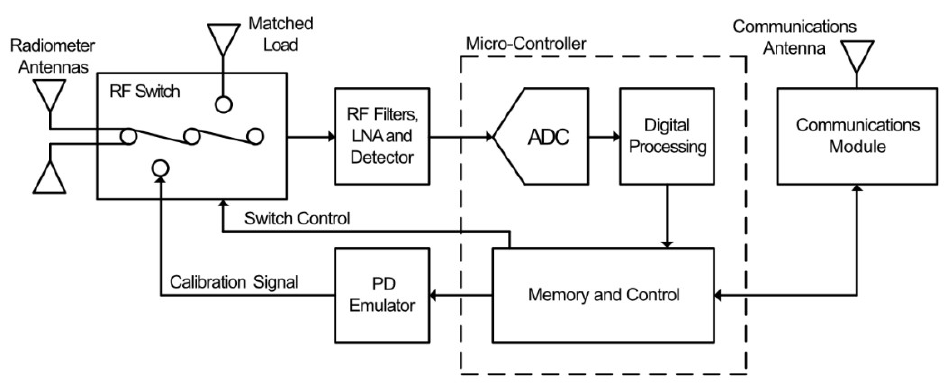
Figure 8. Advanced single channel PD sensor proposed in [72].